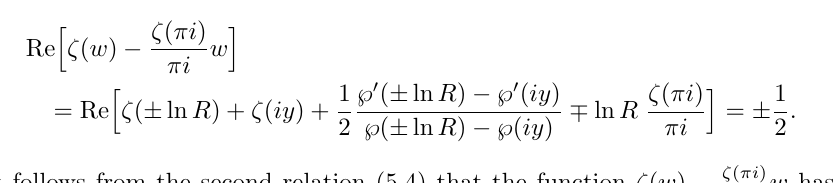
, u 0 = 0 . 3; b) 2 , u 0 = 2